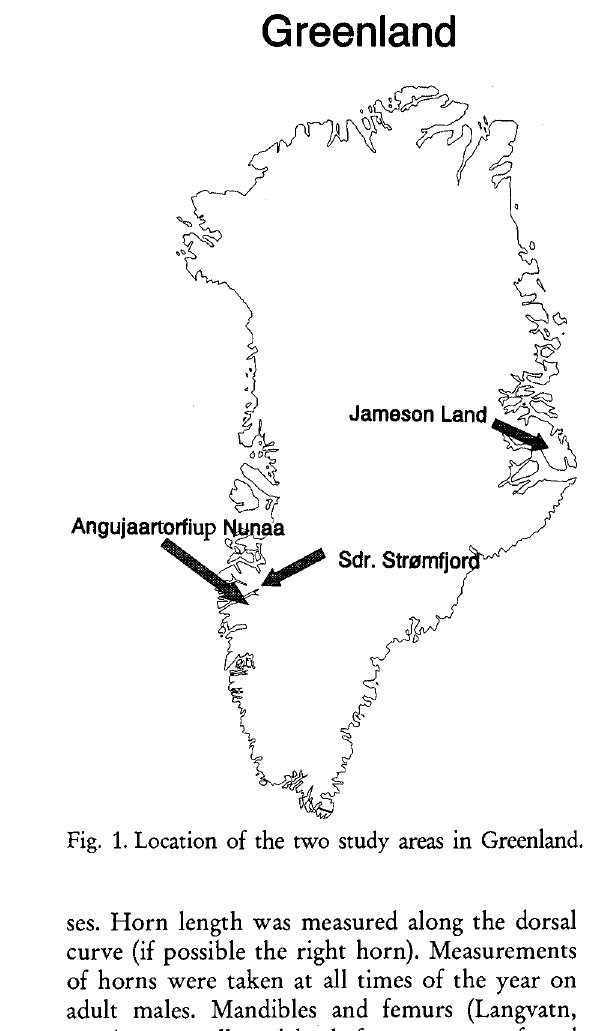
ses. Horn length was measured along the dorsal curve (if possible the right horn).